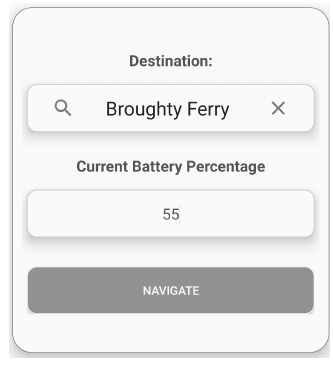
Figure 5. Navigate option with Broughty Ferry as the